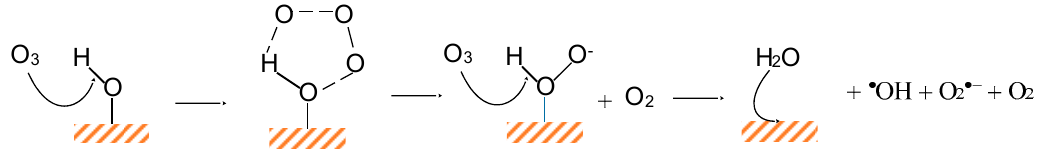
Figure 7. Scheme of ozone reactions with the hydroxyl groups on the FeOOH surface for the production of hydroxyl radicals (Adapted from [83]).